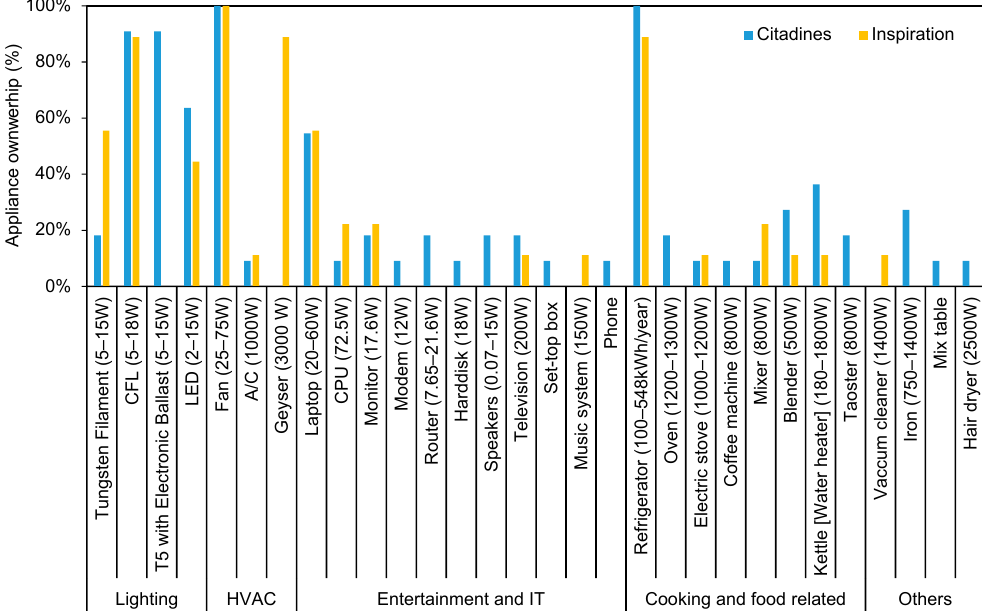
Figure 2. Appliance ownership in monitored households.